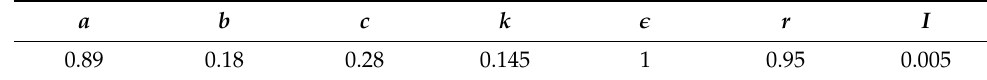
Table 1. The value of parameters for